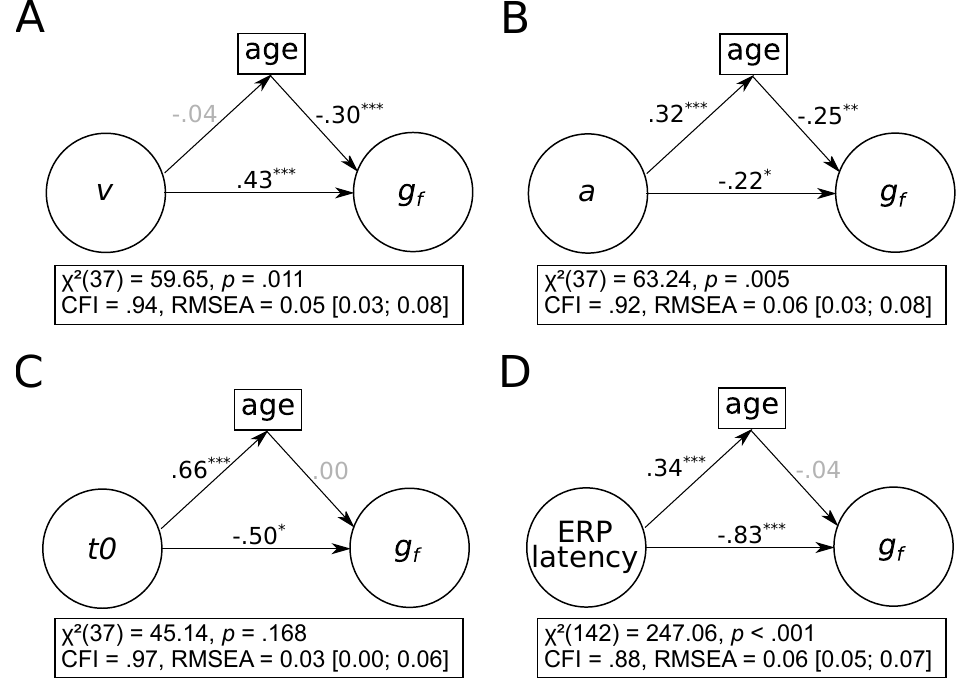
Figure 5. Latent mediation models for each of the four process-related parameters. ( A ) Drift rate. ( B ) Boundary separation. ( C ) Non-decision time. ( D ) ERP latency. Standardized regression weights are shown next to paths with non-significant regression weights shaded in gray. v = drift rate; a = boundary separation; t 0 = non-decision time; ERP = event-related potential; g f = fluid intelligence. N =